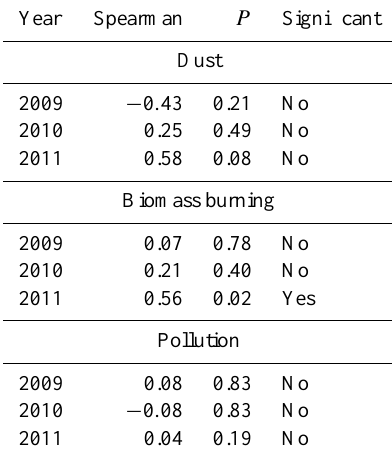
Table 2. Spearman’s correlation coefficients P values, and statisti- cal significance of relationships between similar particle types that were found in the precipitation samples and ambient aerosols during the same time period of precipitation